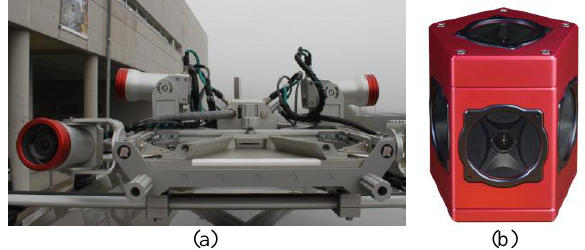
Figure 1. a) VMX-250-CS6 Camera System supporting up to six digital color cameras. b) LADYBUG with a set of six SONY CCD cameras arranged in a similar circular five-camera configuration plus a single vertical camera. ( Source: Point Grey Research, 2011 )